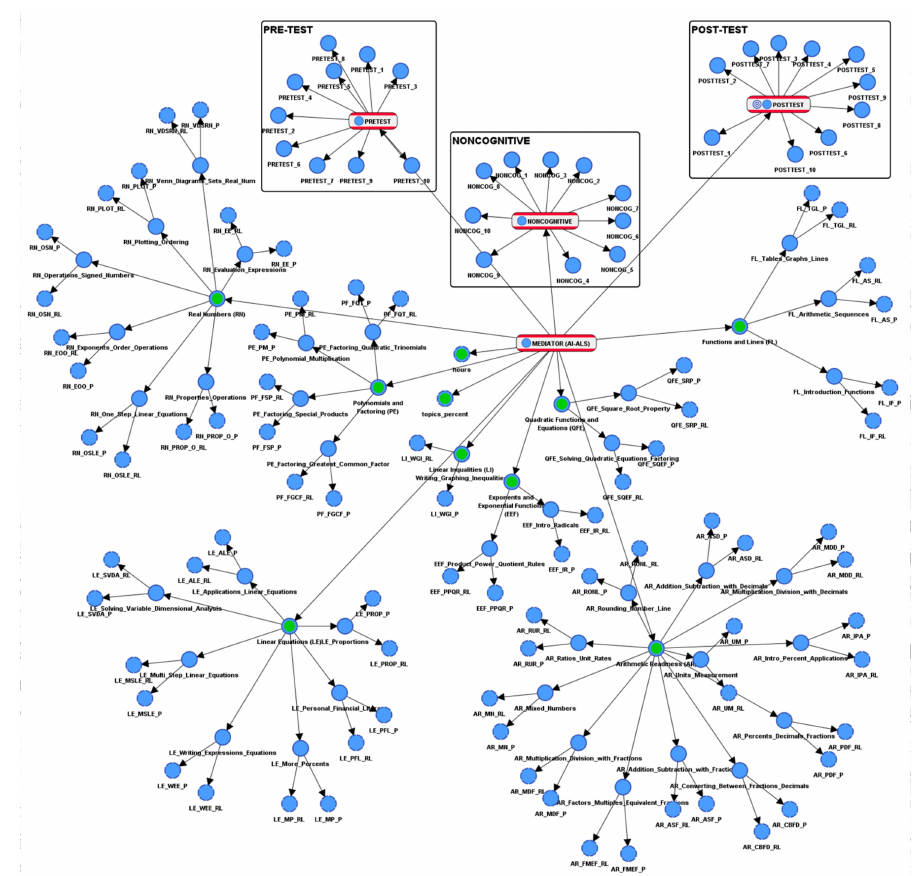
Figure 1. Full view of the Bayesian network: the component nodes (in blue) and the superordinate factor nodes (in green) were used for machine learning the overall performance of 100 students who had used the five di ff erent artificial intelligence-enabled adaptive learning systems